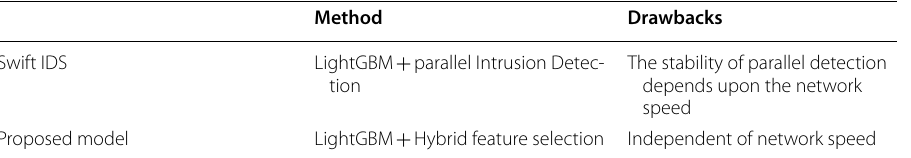
Table 11 Comparison of the proposed model with existing Swift IDS